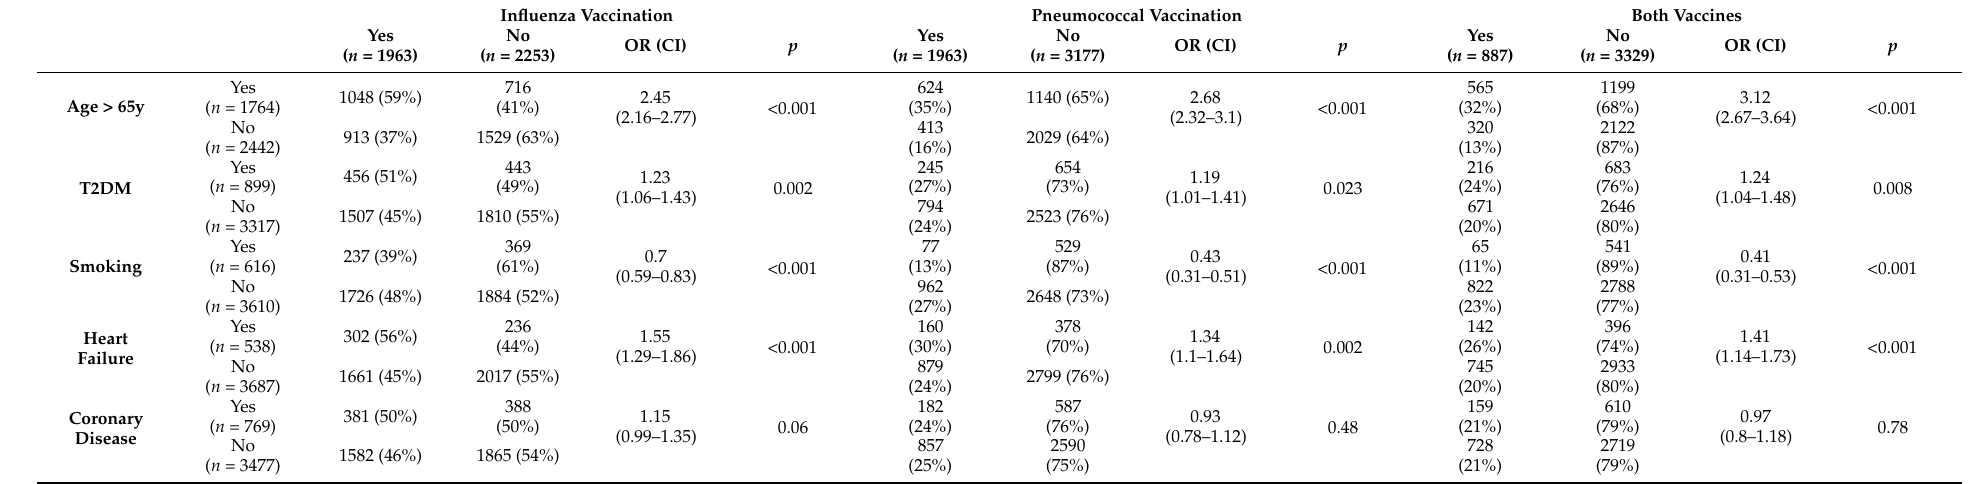
Table 2. Rate of immunization with Influenza vaccine, Pneumococcal vaccine, and double vaccination in specific risk